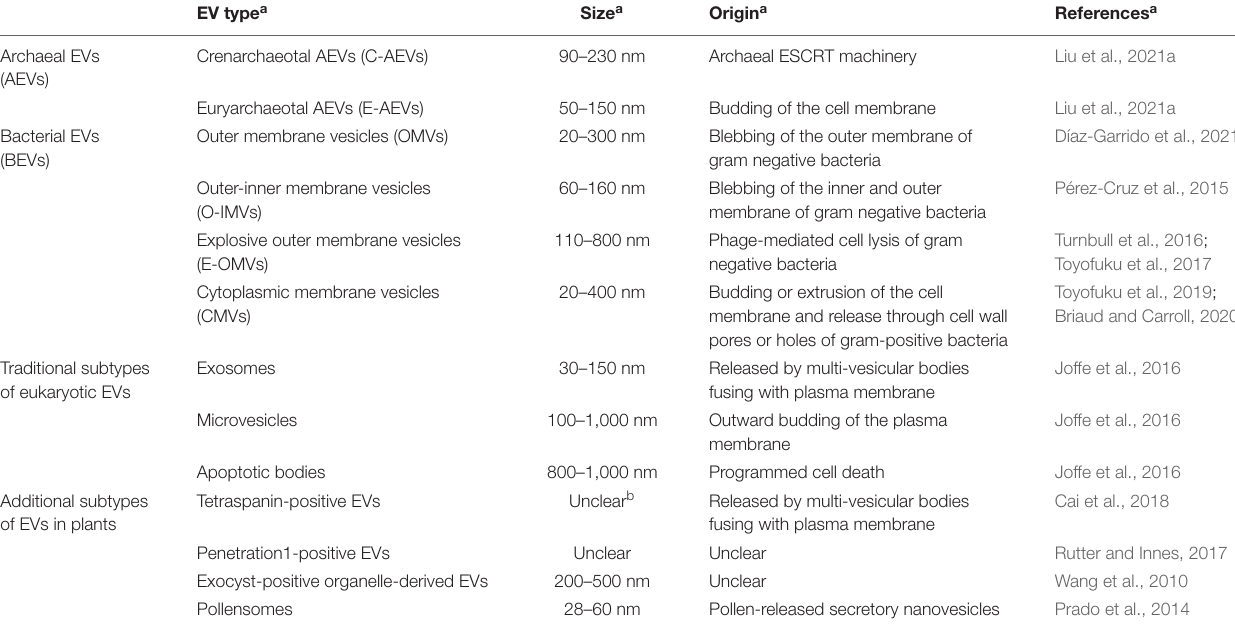
TABLE 1 | Characteristics and biogenesis of different extracellular vesicles